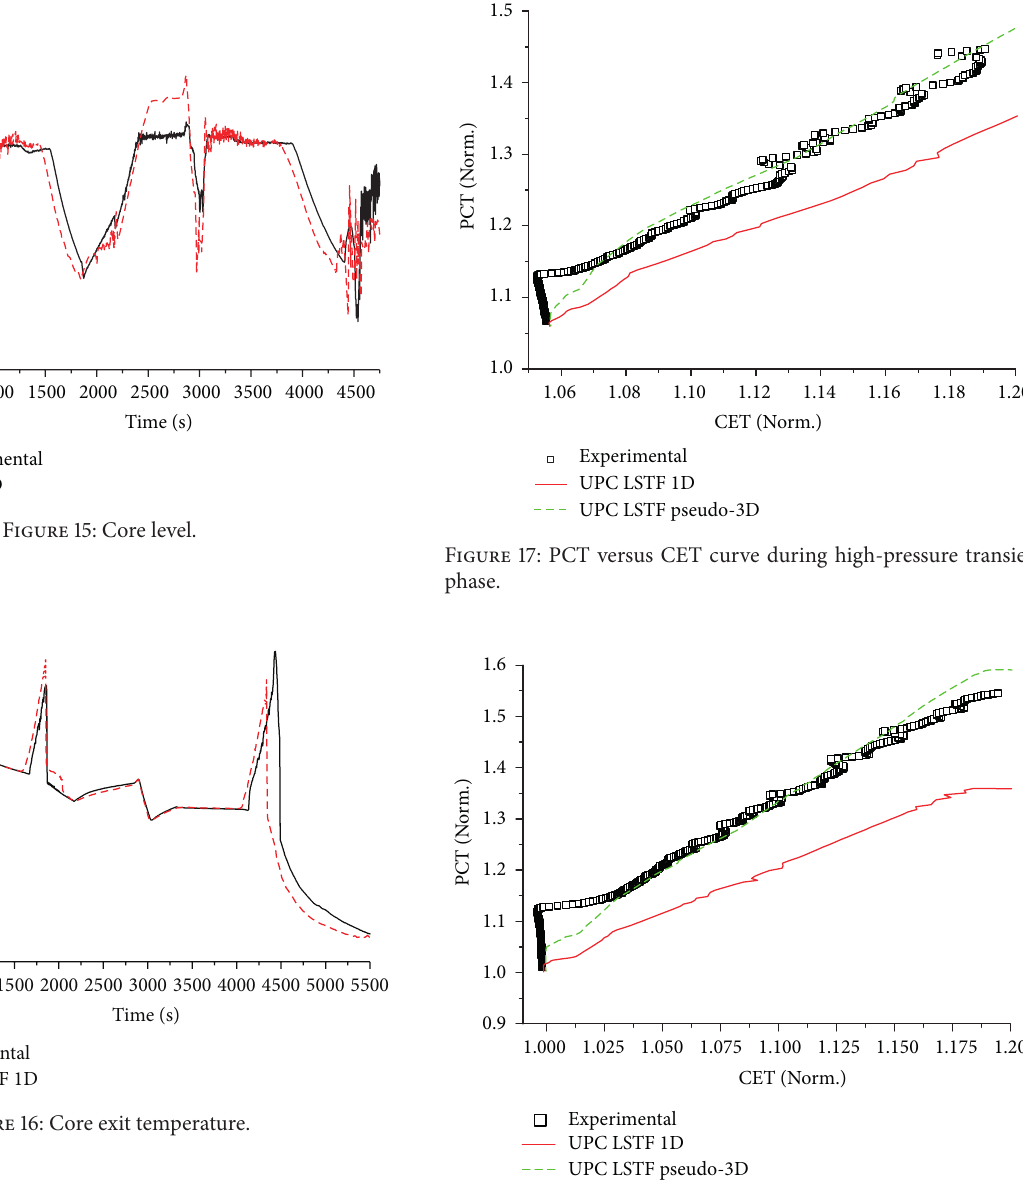
Figure 18: PCT versus CET during low-pressure transient